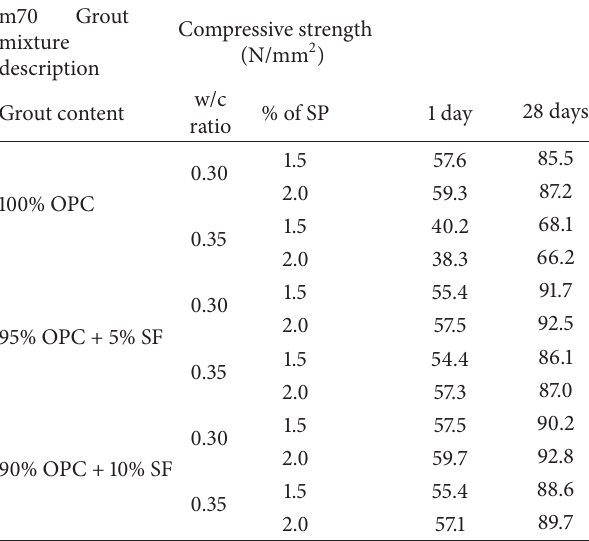
Table 2: Influence of silica fume replacement on the compressive strength